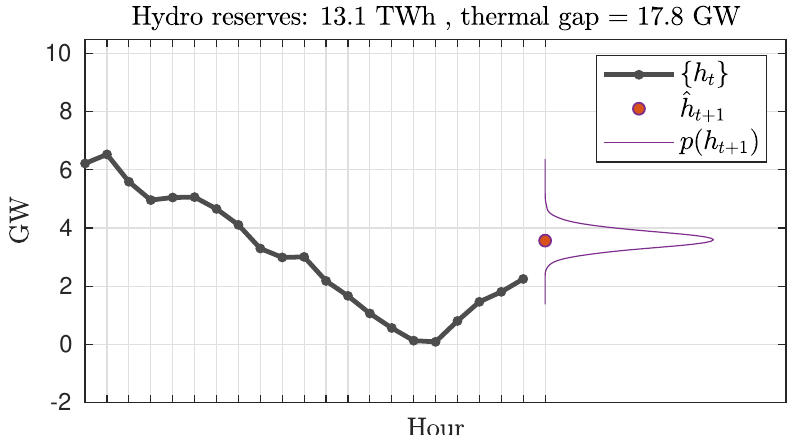
Figure 3. Example of the predictive density of the hydropower generation provided by the statisti- cal